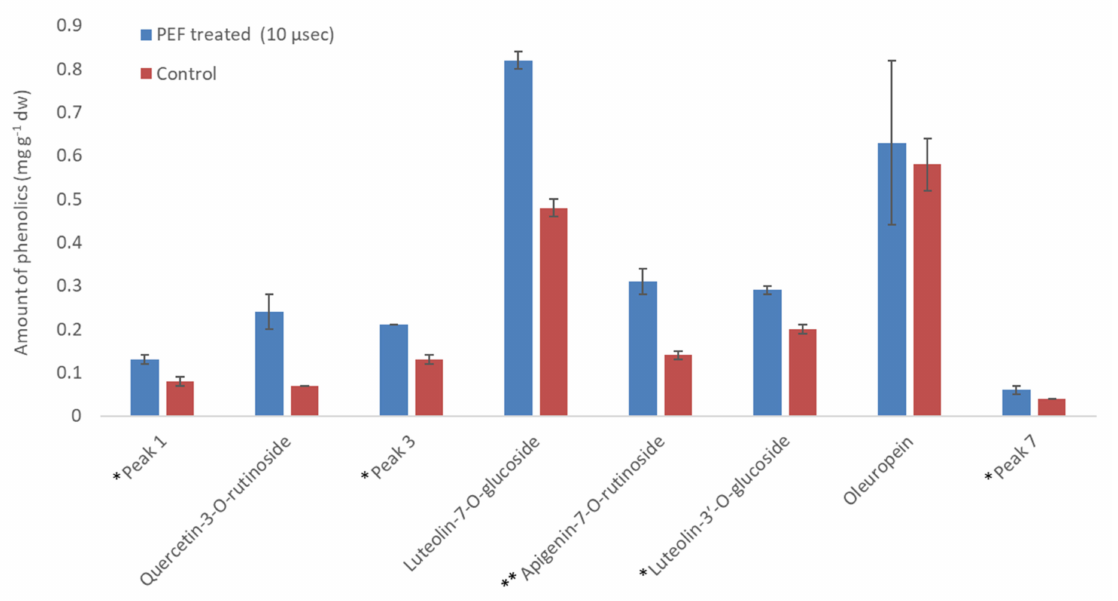
Figure 9. Amount of phenolics (mg g − 1 dw) in PEF-treated leaves versus control at 10 µ s pulse duration and 25% EtOH. * Luteolin-3 (cid:48) -O-glucoside and peaks 1,3 and 7 were quantified as luteolin-7-O-glucoside; ** Apigenin-7-O-rutinoside was quantified as apigenin.